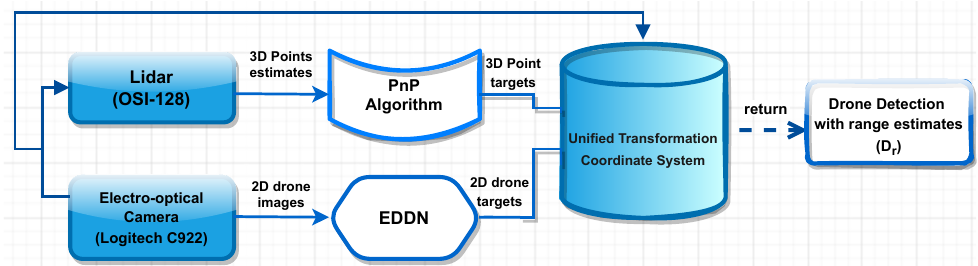
Figure 3. Logic flow of the efficient drone and ranging detector (EDRD) indicating how the drone images from the electro-optical camera and the ranging estimates from the lidar converge for efficient detection estimation and